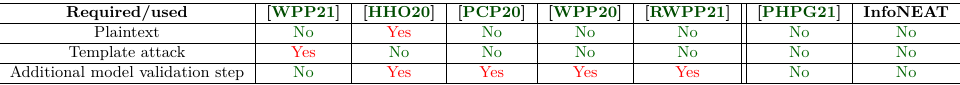
Table 4: Qualitative comparison between important characteristics of the methodologies applied against ASCAD var